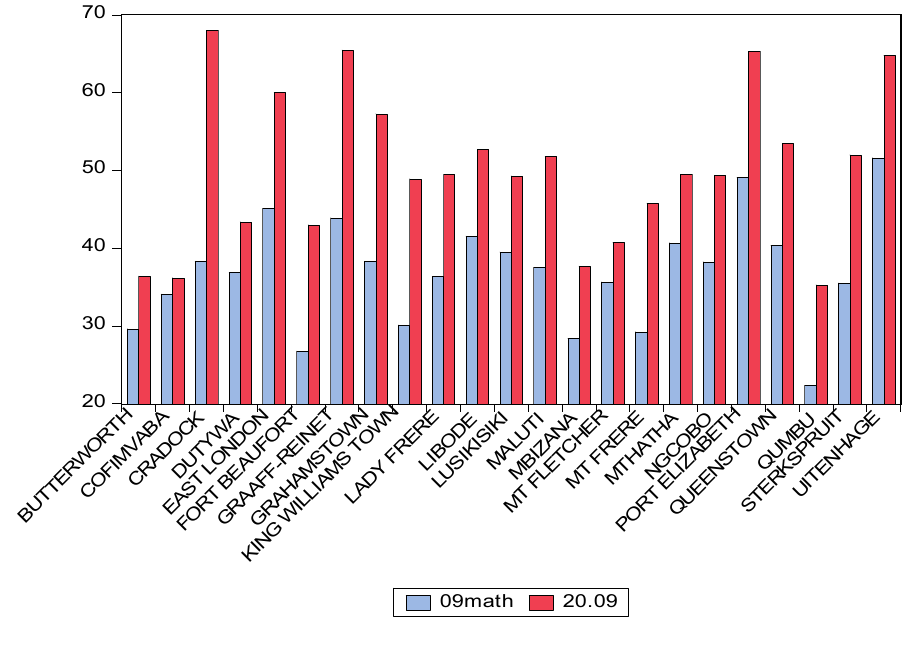
Figure 3: Grade 12 and Mathematics pass rate at district level,